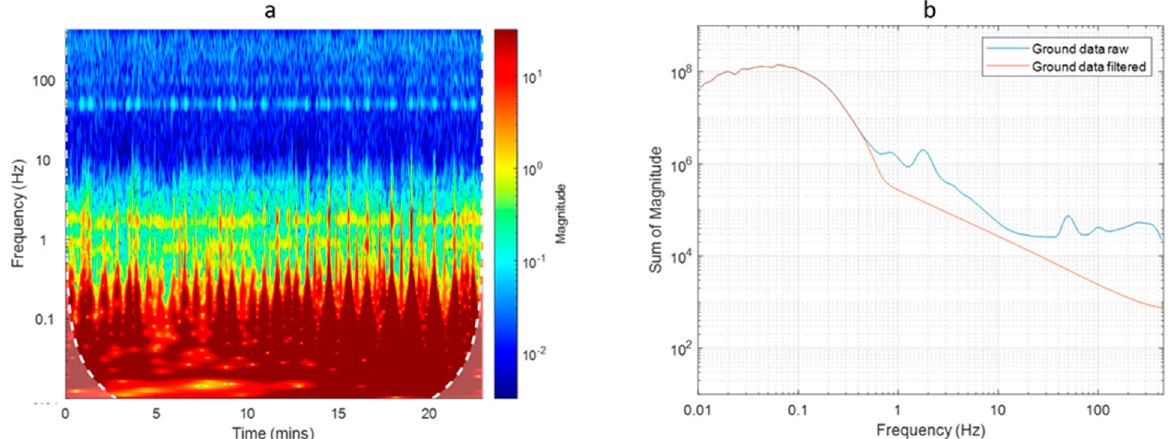
Figure 10. Spectral analysis of ground data. ( a ) Scalogram of ground data. Edge effects in the computation of the spectrum may be significant in the dimmed area below the dashed white line; ( b ) sum of power of the scalogram for each frequency.